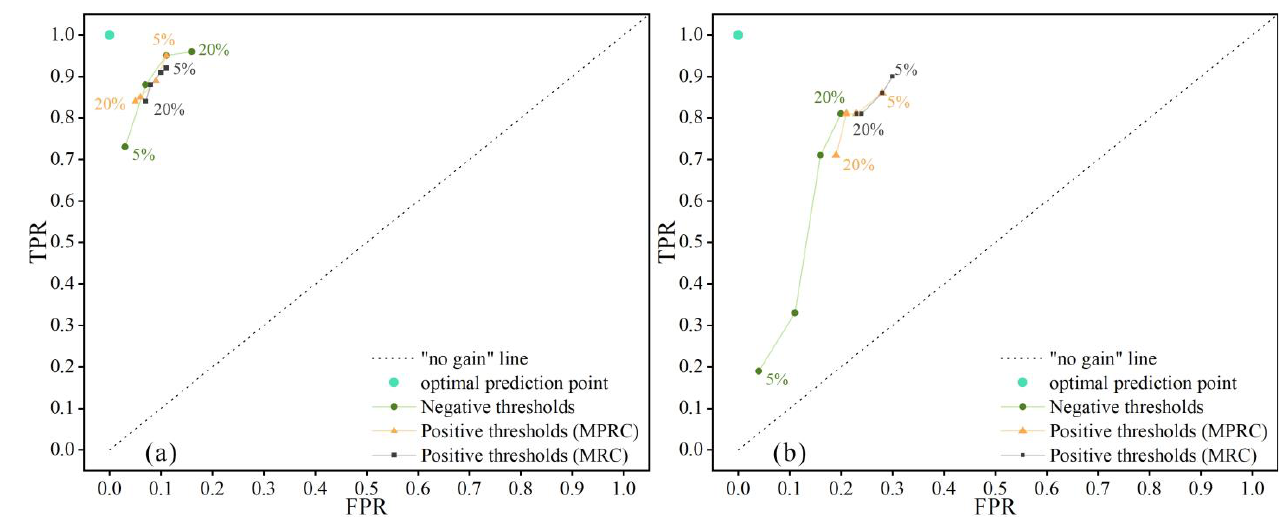
Figure 9. ROC curves for defined rainfall thresholds: ( a ) LY county; ( b ) XY county. Each point represents a threshold at a different non-exceedance/exceedance probability.